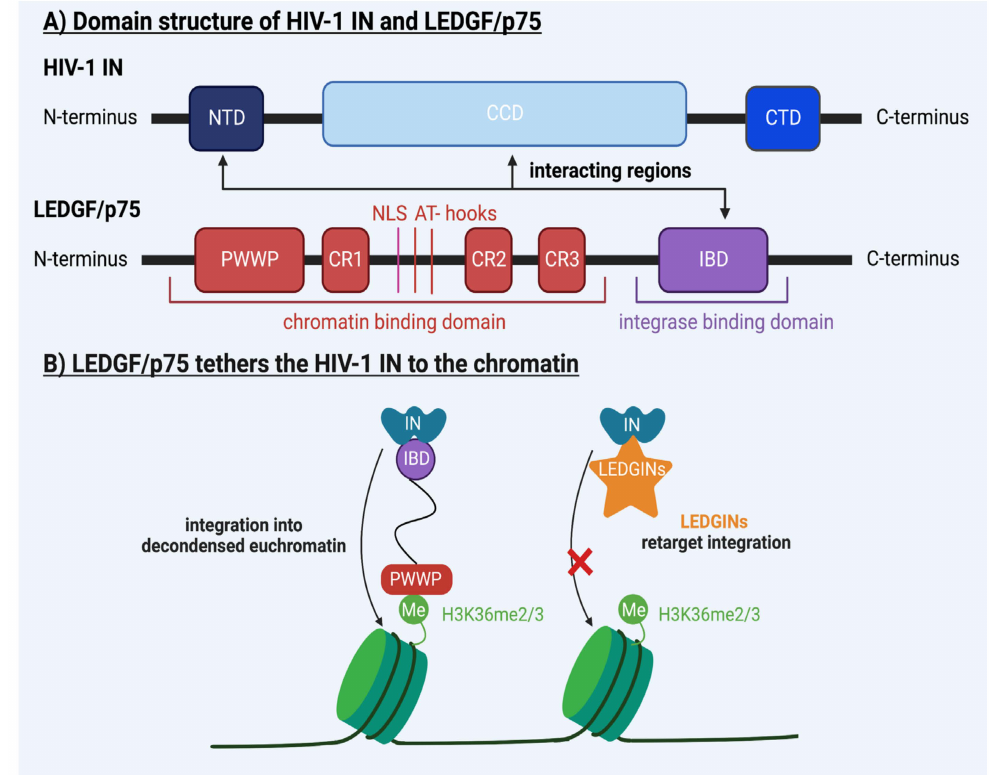
Figure 2. ( A ) Domain structure of HIV-1 integrase (IN) and lens epithelium–derived growth factor (LEDGF/p75). HIV-1 IN consists of an N–terminal domain (NTD), a catalytic core domain (CCD) and a C–terminal domain (CTD) [3]. LEDGF/p75 consists of an integrase–binding domain (IBD), binding the viral IN, and a PWWP domain, binding epigenetic marks in the genome associated with active transcription such as H3K36me2/3 [38–42]. ( B ) LEDGF/p75 tethers HIV-1 IN to chro- matin. LEDGF/p75 simultaneously binds HIV-1 IN with its integrase–binding domain (IBD) and chromatin through its PWWP domain, tethering HIV-1 IN to decondensed chromatin regions, tagged by H3K36me2/3 [38–42]. HIV-1 integration can be targeted away from H3K36me2/3 with the use of LEDGINs, small molecules that inhibit the interaction between HIV-1 IN and LEDGF/p75 [22,23]. (Figure created with Biorender.com on 17 December